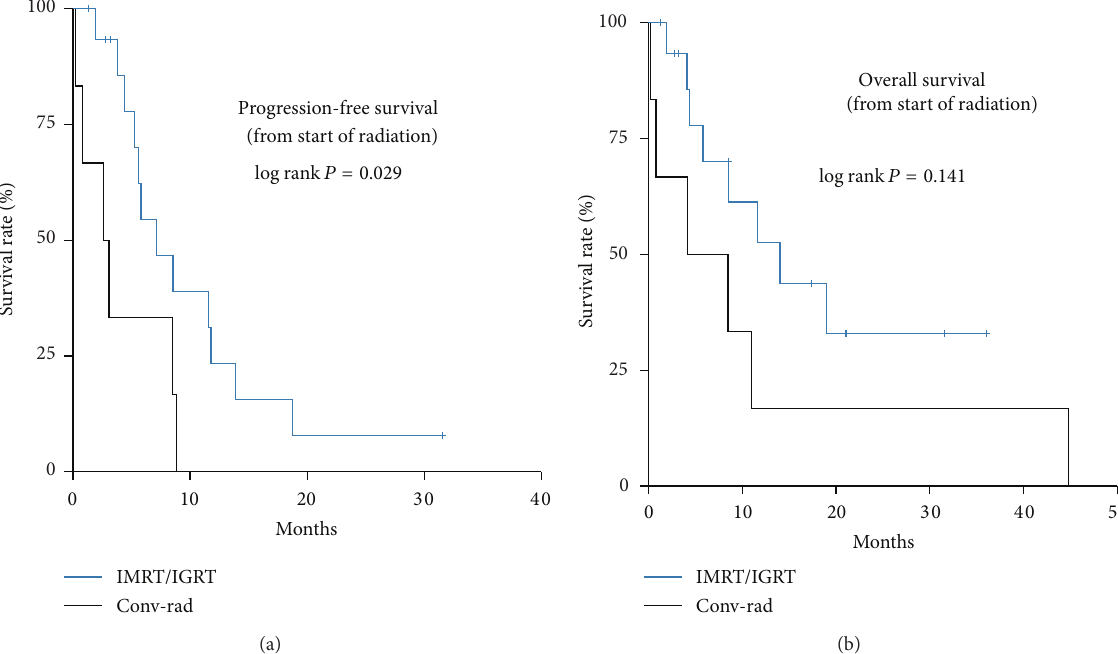
Figure 2: PFS and OS IMRT/IGRT versus conventional radiotherapy calculated from the start of RT.